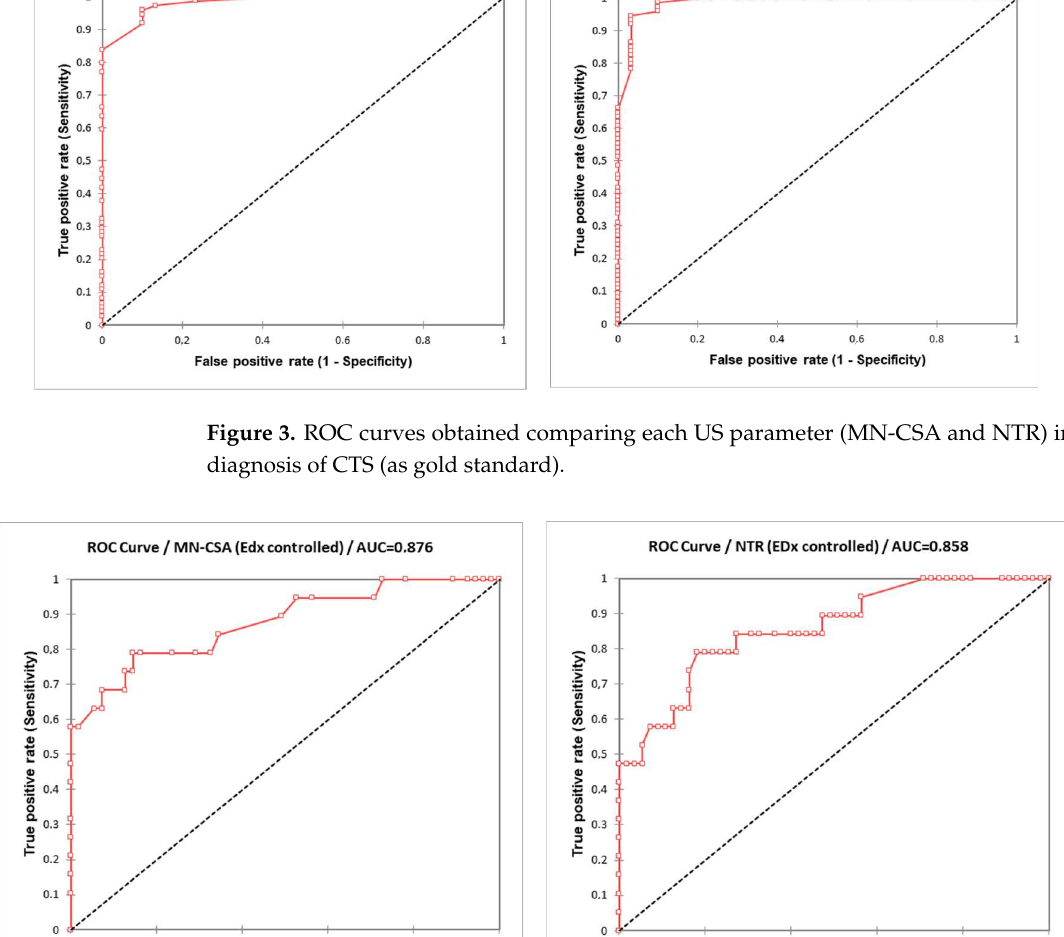
Figure 3. ROC curves obtained comparing each US parameter (MN-CSA and NTR) in the clinical diagnosis of CTS (as gold standard).